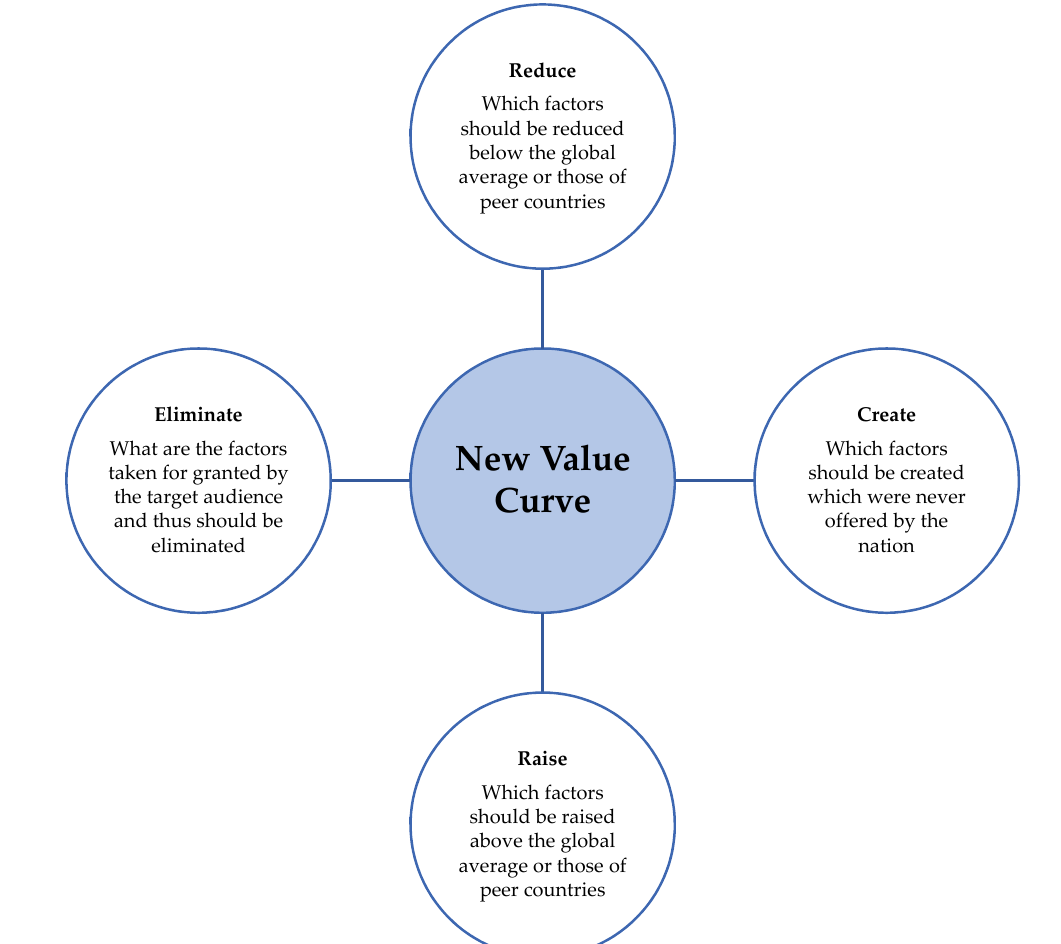
Figure 1. Applied Four Actions Framework for nation branding. Source: developed by authors (2021).